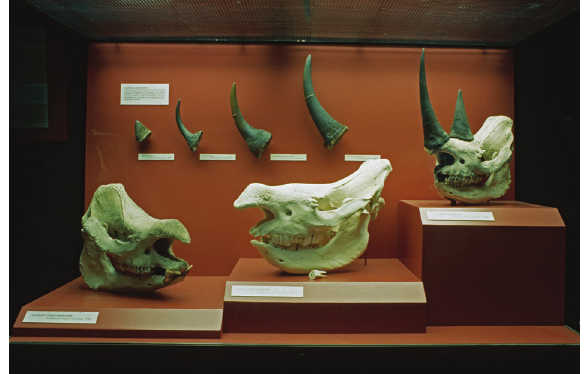
Figure 1. The horns and skulls, respectively, of five rhinocer - oses as presented on display in the exhibition of the Zoological Museum in Hamburg since the 1980s. Among them was also a horn of the extremely rare Rhinoceros sondaicus from West Java. The complete set of horns was stolen from this showcase in June 2011 [photograph courtesy of Harald Schliemann].